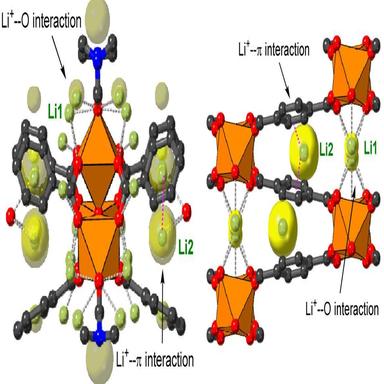
Two crystallographic sites Li1 and Li2 for possible lithium insertion.